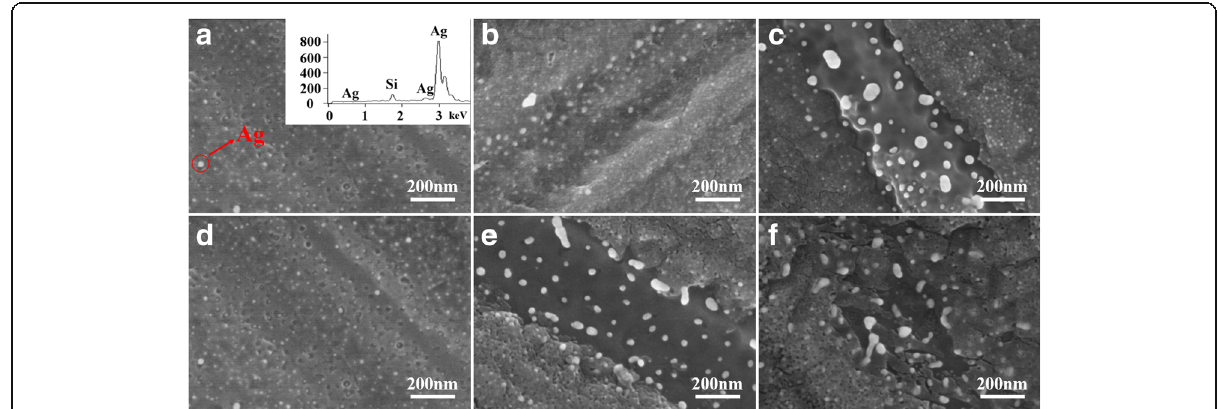
Fig. 1 SEM images of Ag nanoparticles deposited on sc-Si and insert of EDS. SEM images of Ag nanoparticles deposited on sc-Si: a – c deposition for 2 min at 25 °C with Ag ion concentration of 5, 10, and 15 ppm, respectively; and d – f deposition at 25 °C with 5 ppm concentration Ag ion for 2, 4, and 6 min, respectively. EDS result in the inset of a